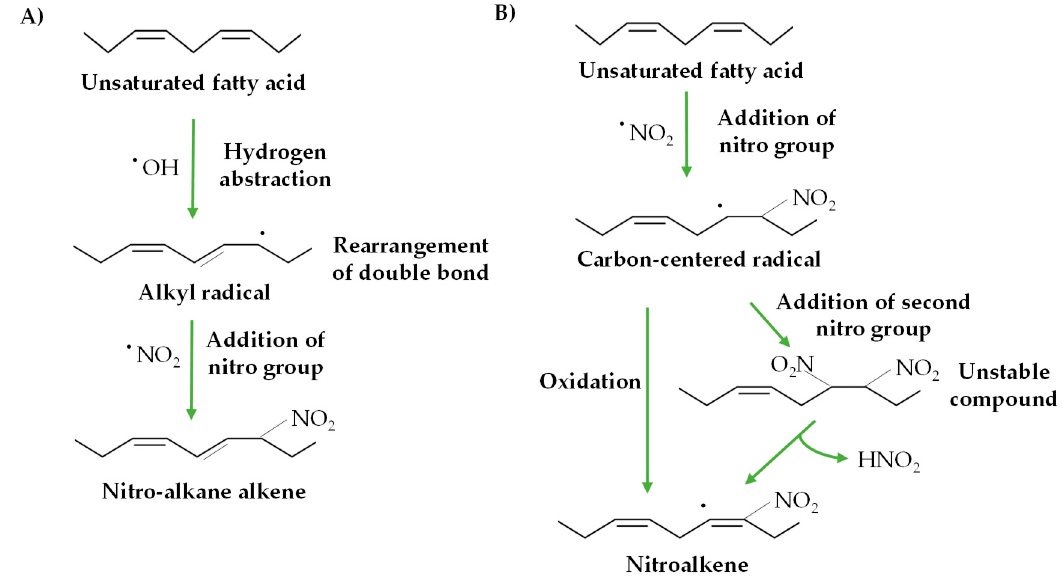
Figure 1. Possible mechanisms of nitrate fatty acid (NO 2 -FA) formation. ( A ) Alkyl radical generation through a radical hydrogen abstraction from a bis-allylic carbon followed by the insertion of NO 2 . ( B ) NO 2 -FA formation by the direct addition of NO 2 and its oxidation (modified from Reference [49]).